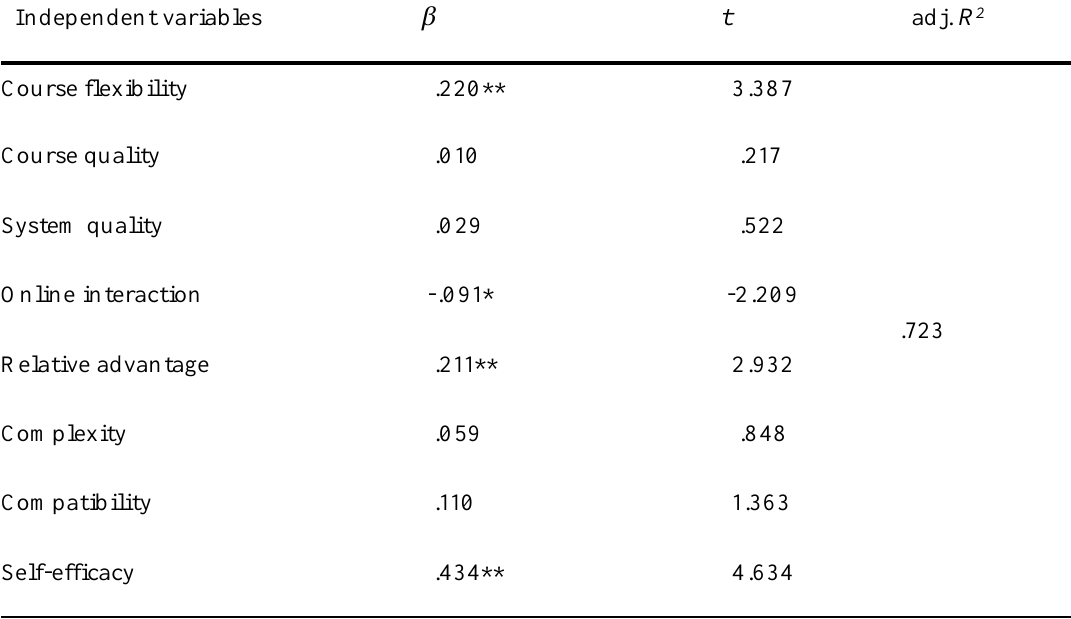
Table 3 Factors Affecting E-Learning Continuance Intention for The High-Degree-Of-Participation